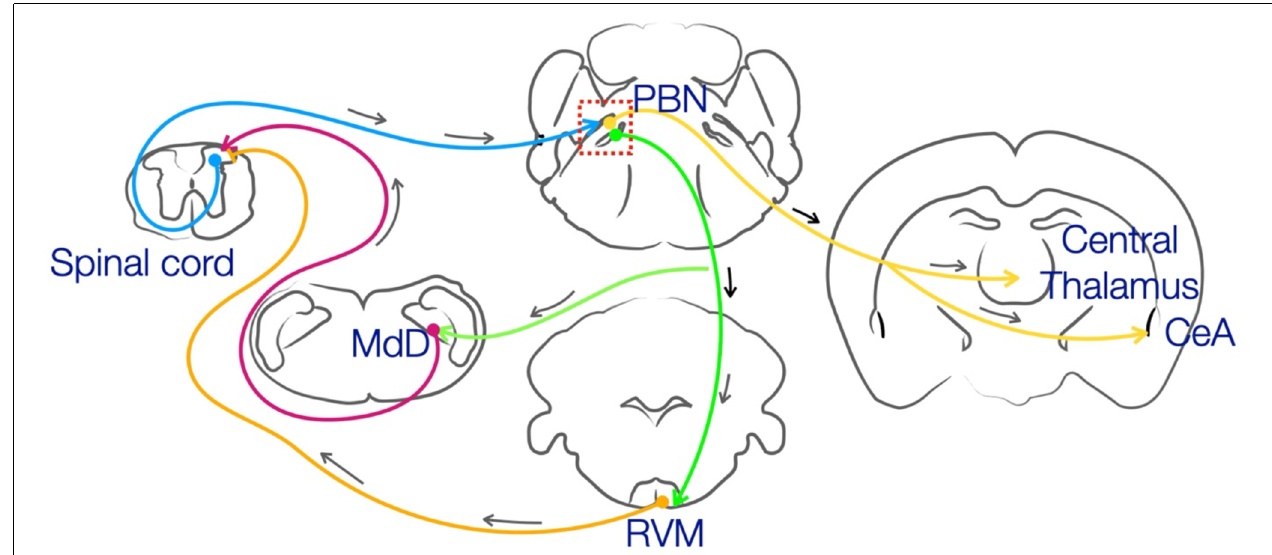
FIGURE 1 | Spinal projection neurons carrying somatosensory information originate from the superficial layers of the dorsal horn and project to the PBN. The information from the PBN is relayed to the mid- and fore-brain regions such as the central thalamus and the CeA to mediate the aversive and emotional effects of pain and itch. Through the projections to the RVM and MdD and their direct connections with the spinal cord neurons, PBN can modulate the threshold for both pain and itch. PBN, parabrachial nucleus; RVM, rostral ventromedial medulla; CeA, central amygdala; MdD, Dorsal Medullary Reticular